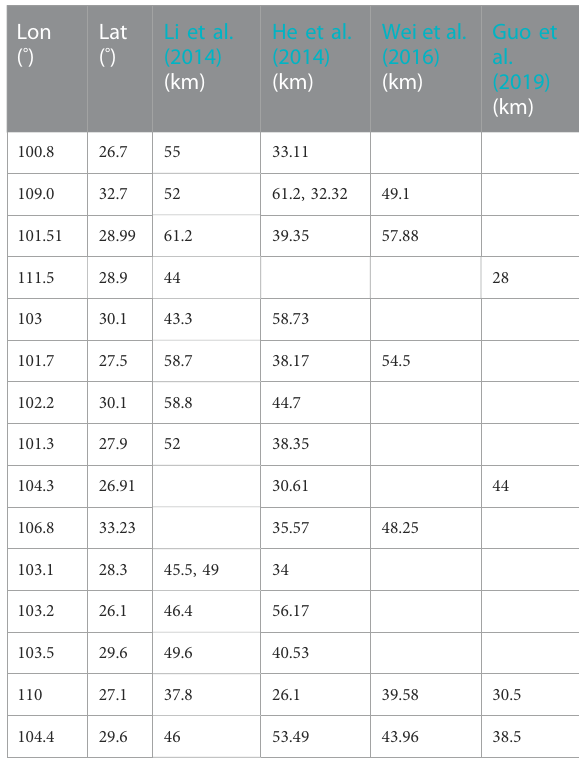
TABLE 2 Information about stations with standard deviation/difference estimates greater than 6